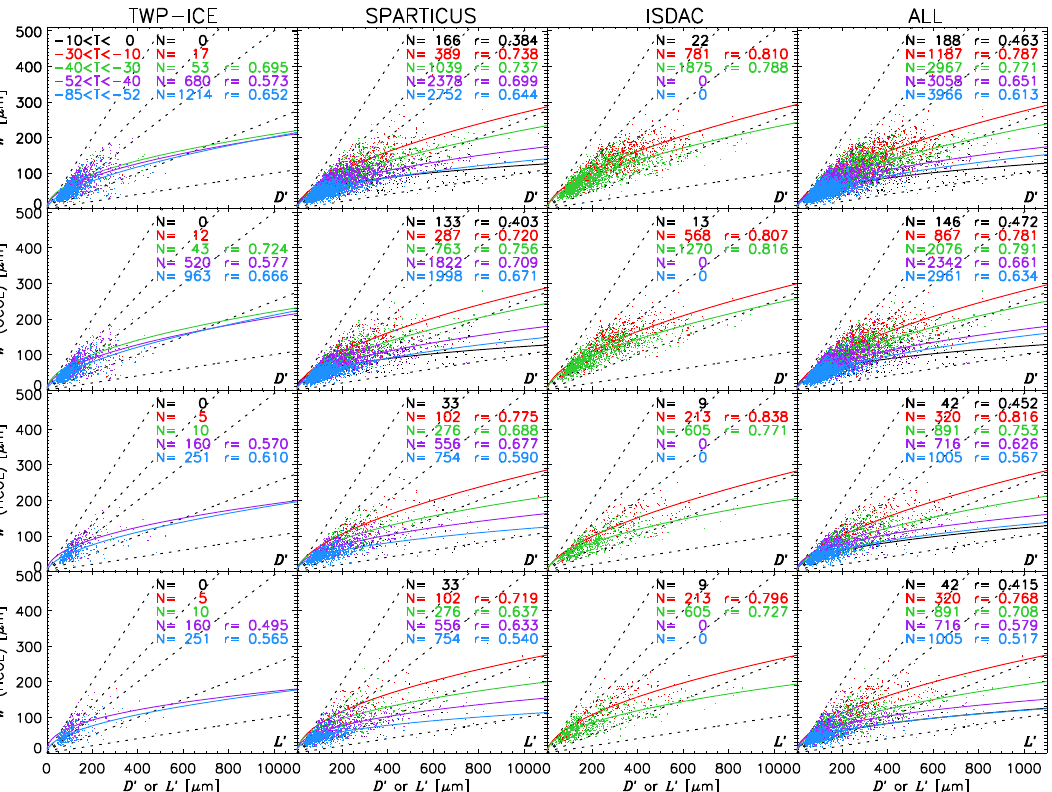
Figure 9. The D (cid:48) – W (cid:48) relationship of all columns (top row), oriented columns (second row, OCOL), and horizontally oriented columns (third row, HCOL) as a function of temperature. Different colors indicate different temperature ranges. Bottom row shows L (cid:48) – W (cid:48) relationships for HCOLs. The number of crystals ( N ) in each temperature range is embedded within each panel. The best fit, y = ax b , is shown with a solid line and correlation coefficient r is indicated in the legend for each T range. The x/y = 1 . 0, 1.5, 2.0, 4.0, and 10.0 lines are indicated with dotted